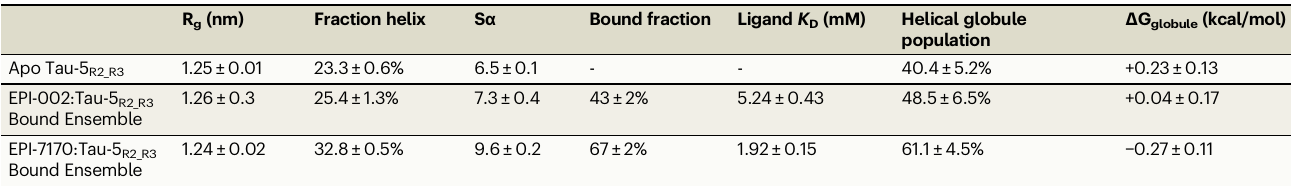
Table 2 | Simulated values and statistical error estimates for propertiesofTau-5 R2_R3 in its apo form and when bound to EPI-002 and EPI-7170 R g